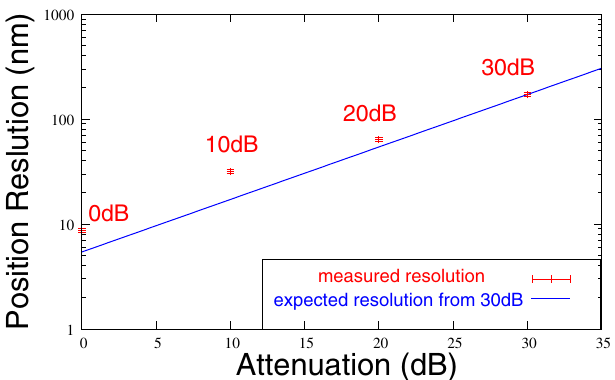
FIG. 19. (Color) Summary of resolution measurements with various settings of the variable attenuator. The line is the extrapolation from the data at 30 dB attenuation